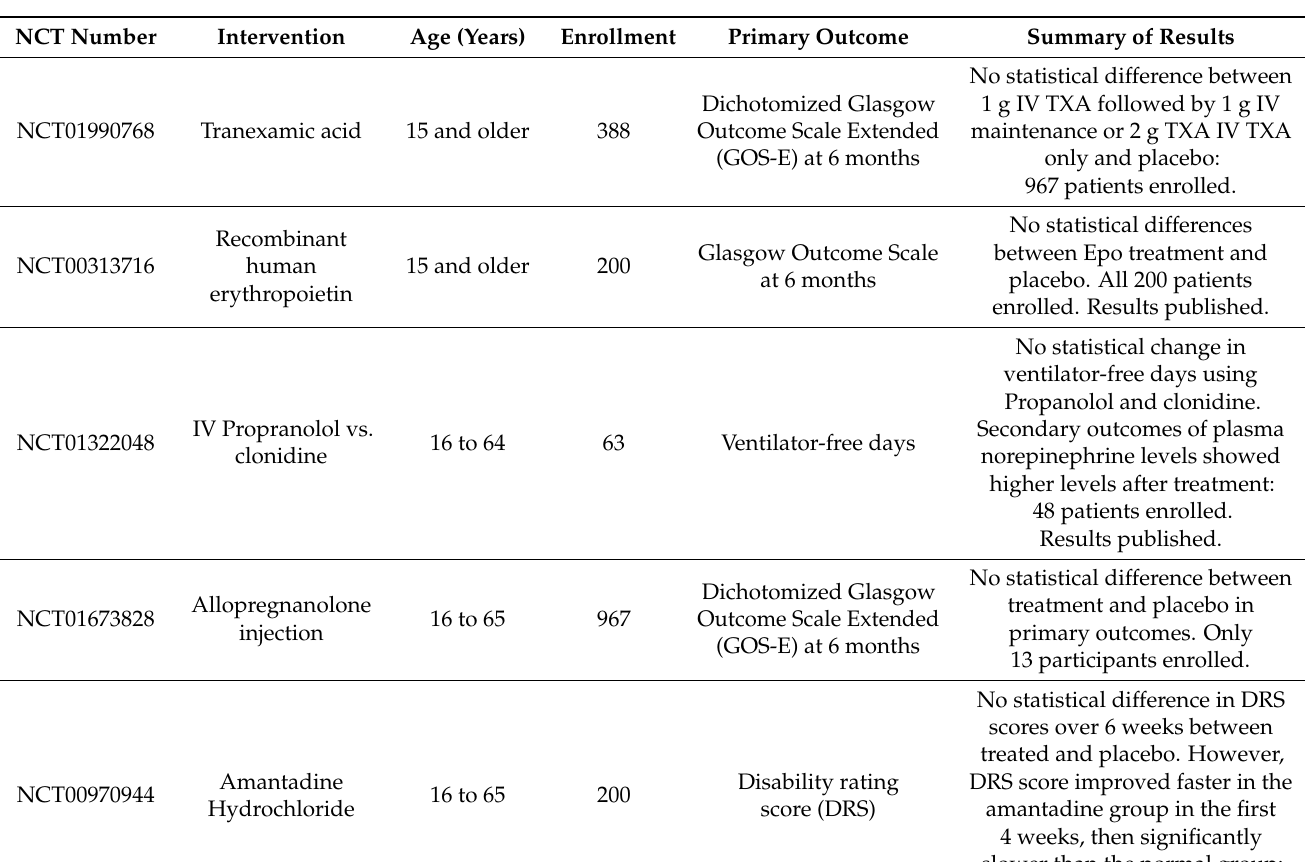
Table 1. Completed studies with results